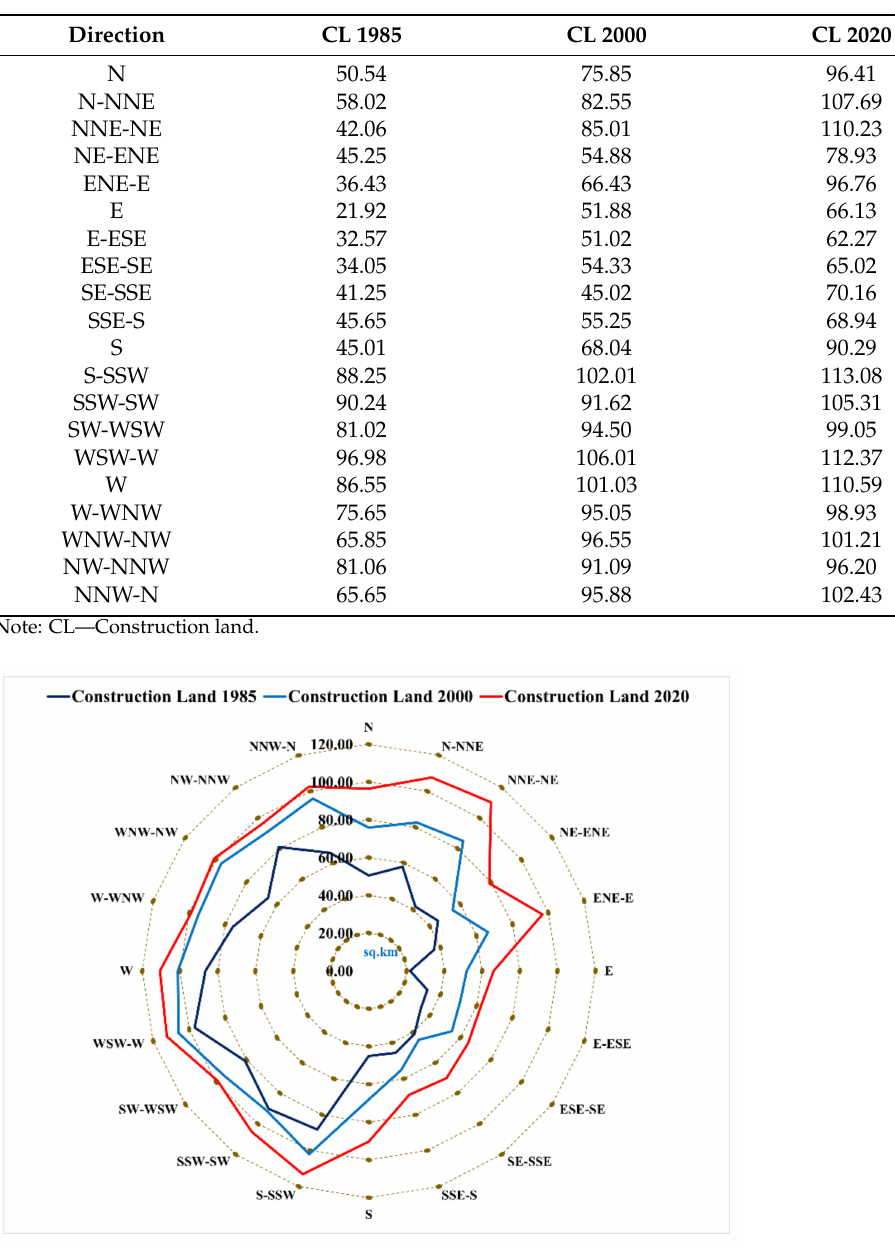
Figure 7. Directional change of urban CL from 1985 to 2020; (Note: Three distinct colors represents three time periods directional change of urban CL such as, deep blue line represent urban CL 1985, light blue line represent urban CL 2000, and red line represent urban CL